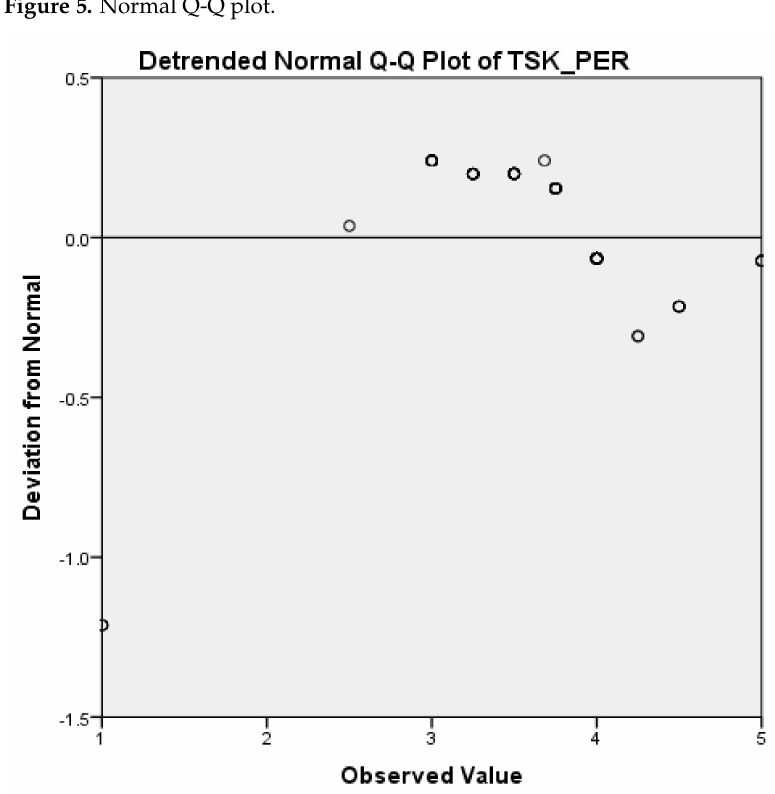
Figure 6. The Detrended Normal Q-Q